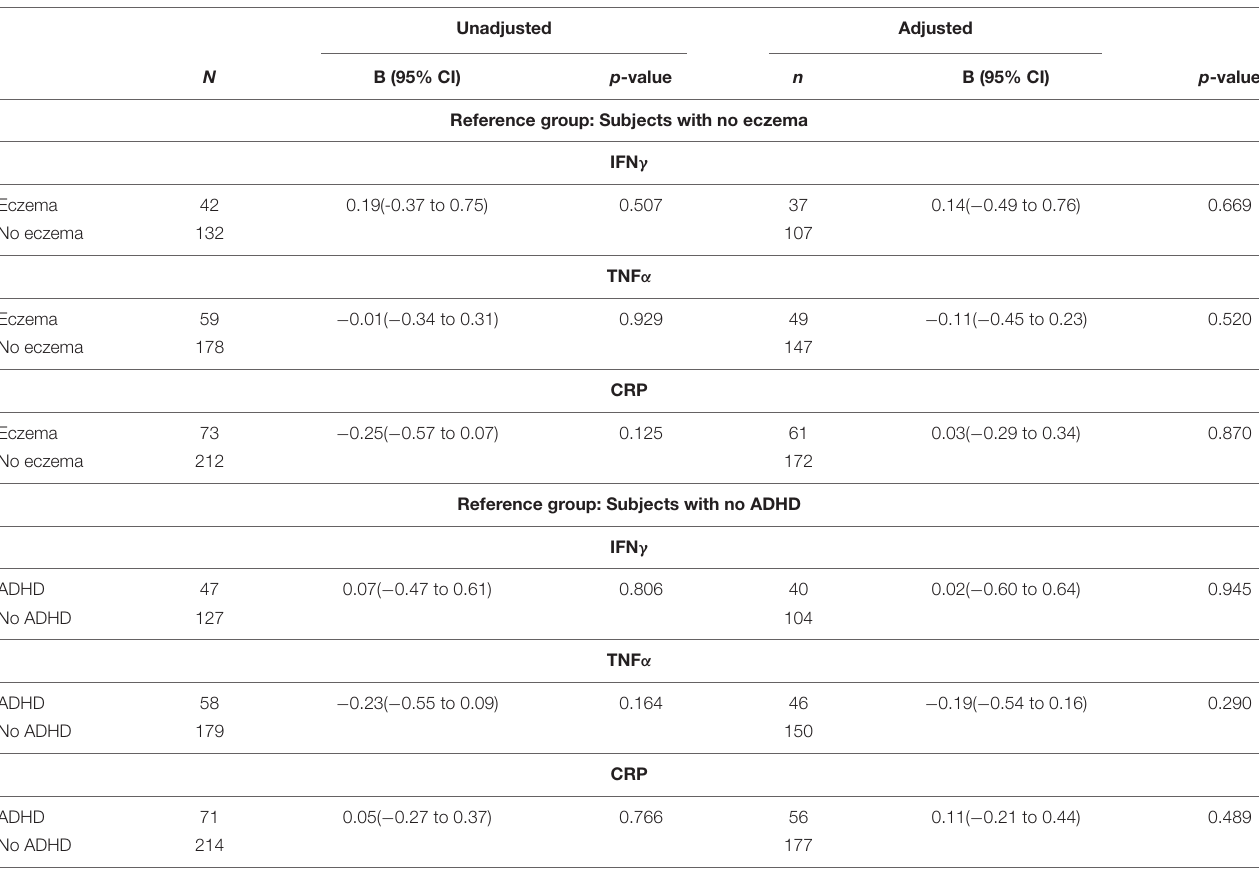
TABLE 2 | Differences in maternal blood